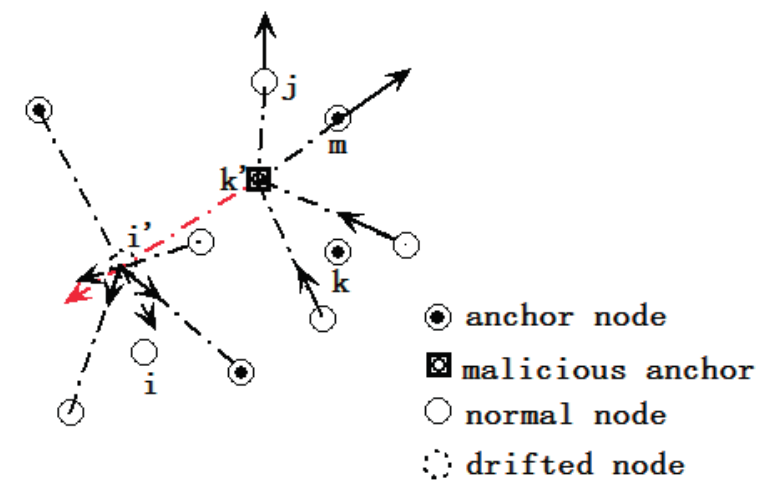
Figure 3. Drifted node and malicious node detection.